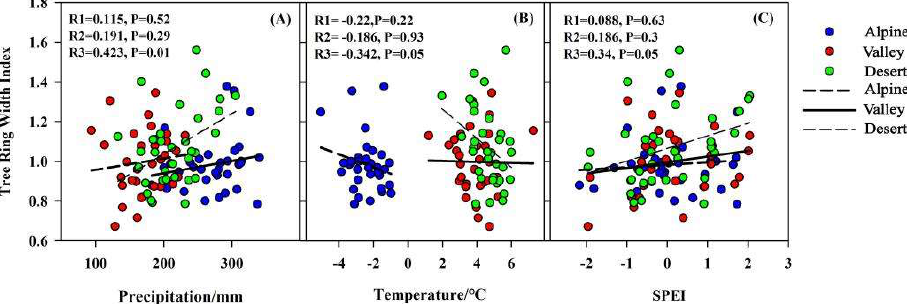
Figure 8. Correlation between TRW and climatic factors. Note: R1, R2 and R3 values in alpine, valley and desert areas are shown in each plot. So is the p value.